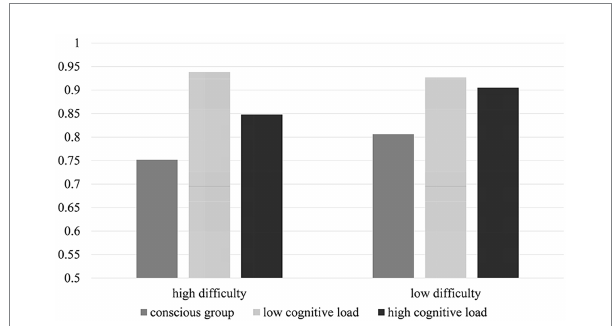
FIGURE 3 The prototype activation rate of Experiment 2.